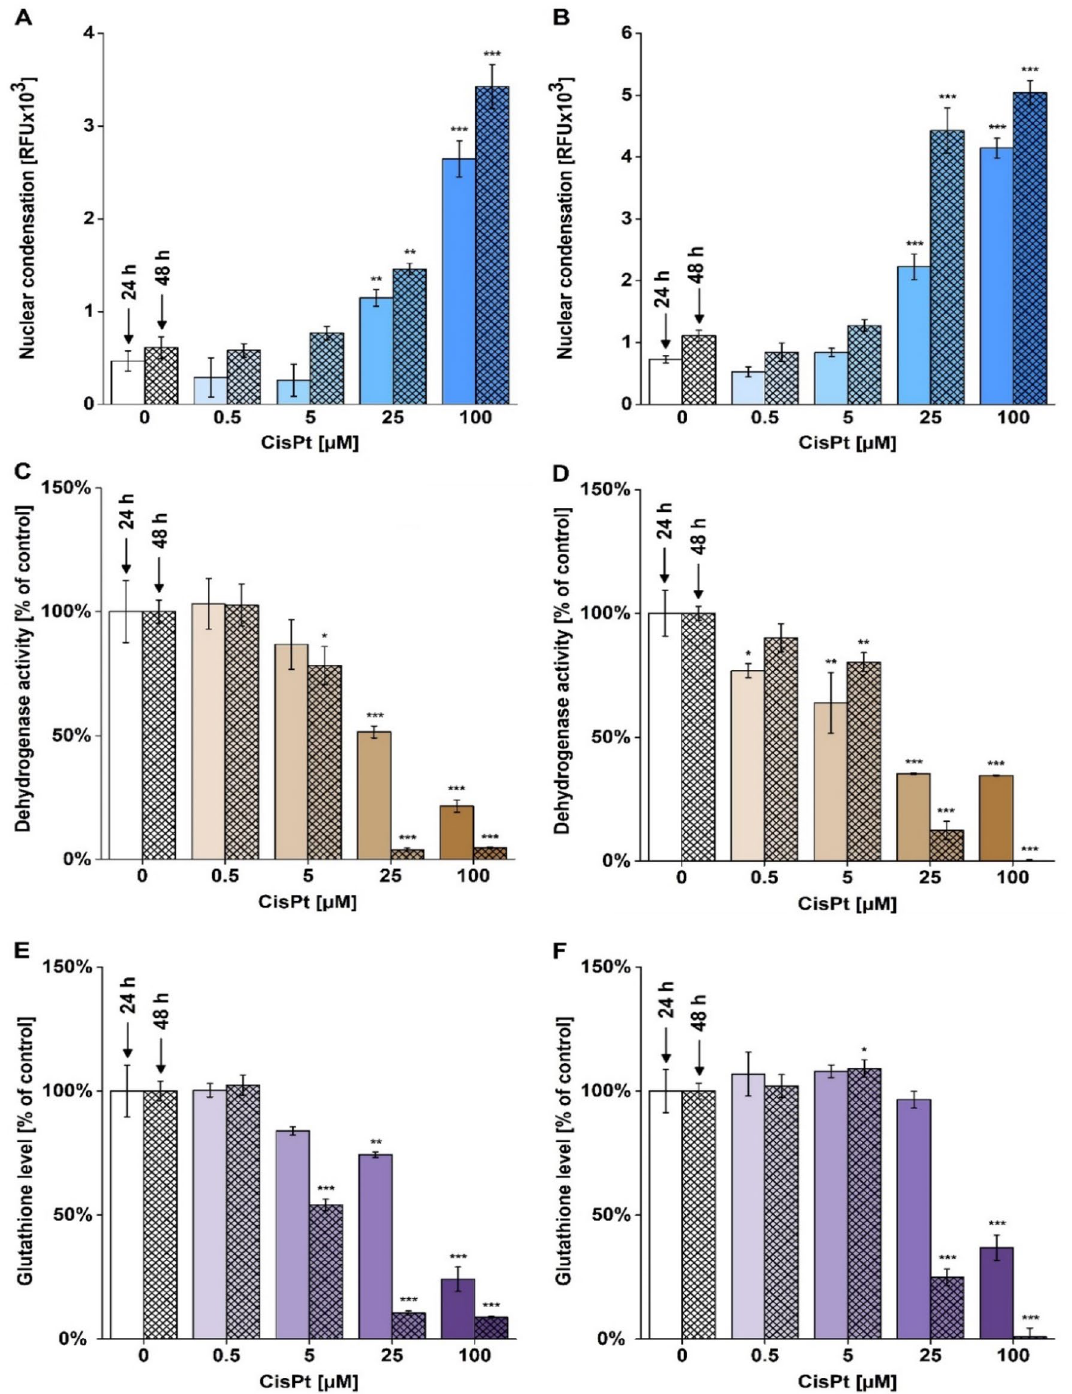
Figure 2. Characterizing cisplatin-induced toxicity in HepG2 and HK-2 cells. HepG2 ( A , C , E ) and HK-2 ( B , D , F ) cells were incubated with cisplatin (CisPt; 0; 0.5; 5; 25 and 100 µM) for 24 and 48 h. After treatment, nuclear condensation and fragmentation using the H33258 spectrofluorometric assay ( A , B ), dehydrogenase activity using the WST-1 test ( C , D ) and glutathione levels using monochlorobimane assay ( E , F ) were measured. The data are presented as mean ± SEM (A, B) and mean ± SD (C-F). (* p < 0.05; ** p < 0.01; *** p < 0.001, vs. untreated cells at appropriate time